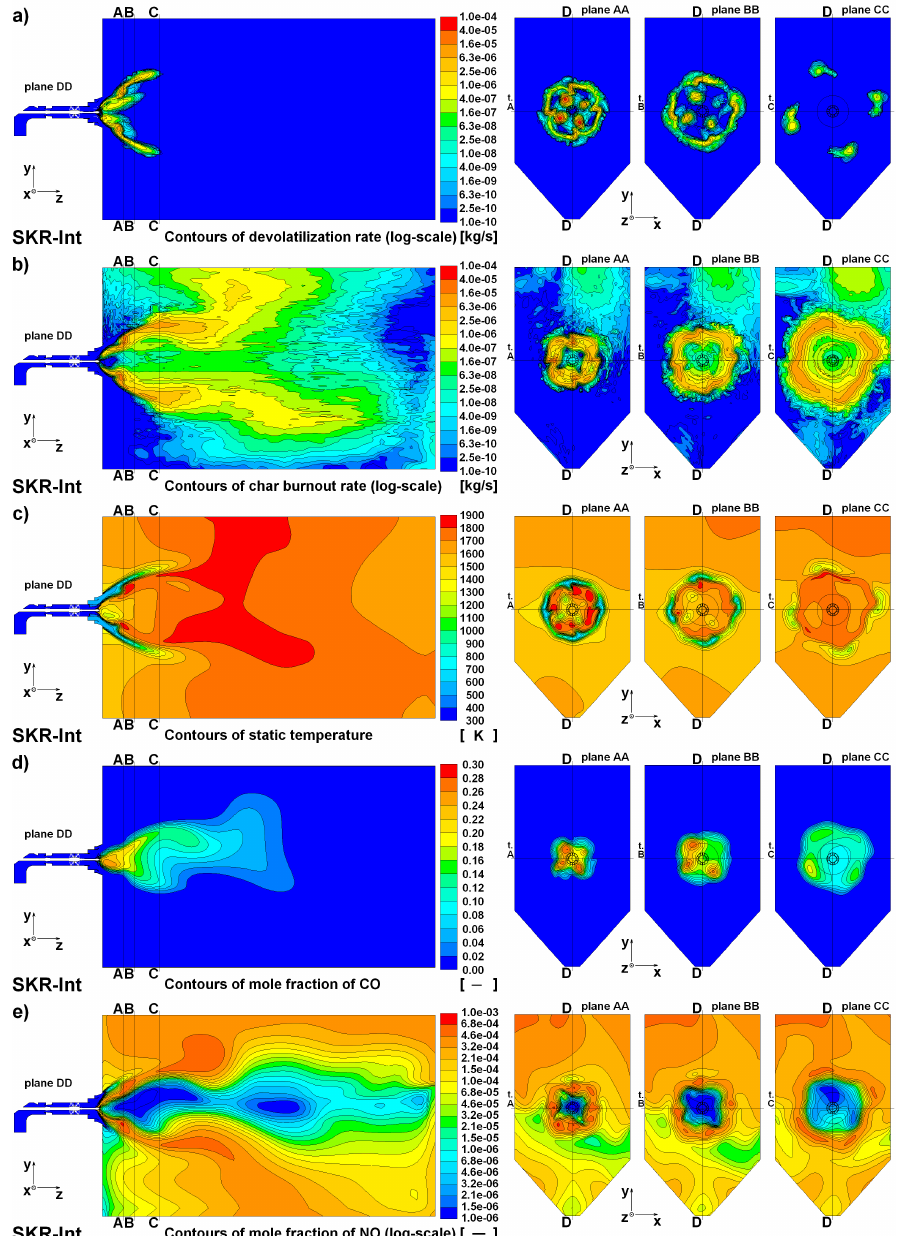
Figure 9. Results obtained by means of the SKR-Int model. ( a ) Devolatilization rate; ( b ) char burnout rate; ( c ) static temperature; ( d ) mole fraction of CO; and ( e ) mole fraction of